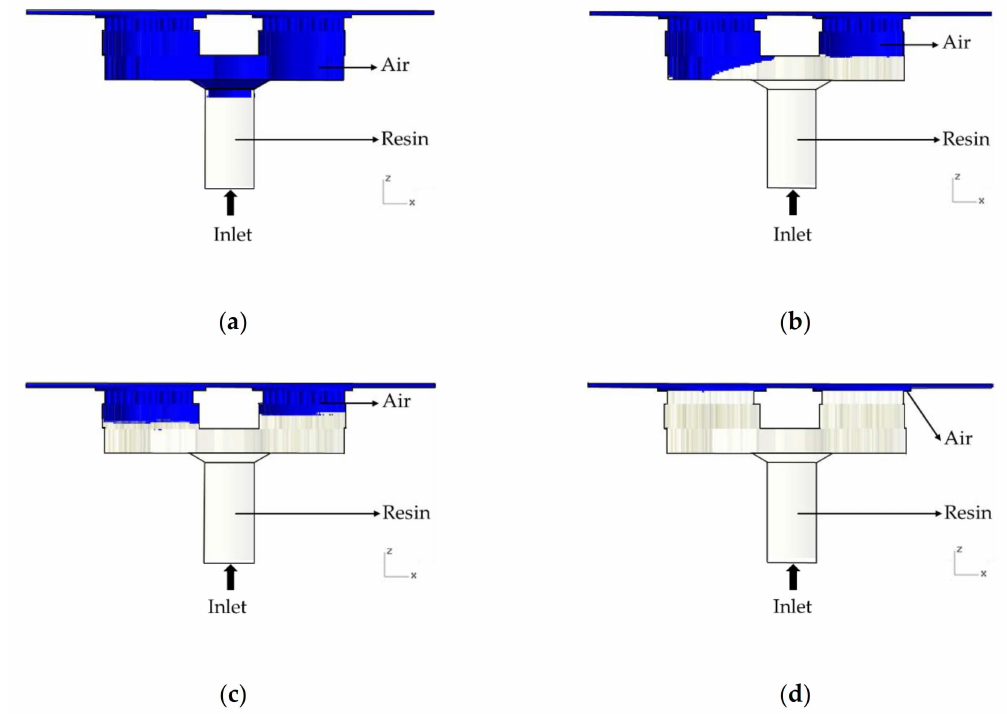
Figure A2. The flow rate is 0.02 cm 3 /s. ( a ) Filling 10%; ( b ) Filling 30%; ( c ) Filling 50%; ( d ) Filling